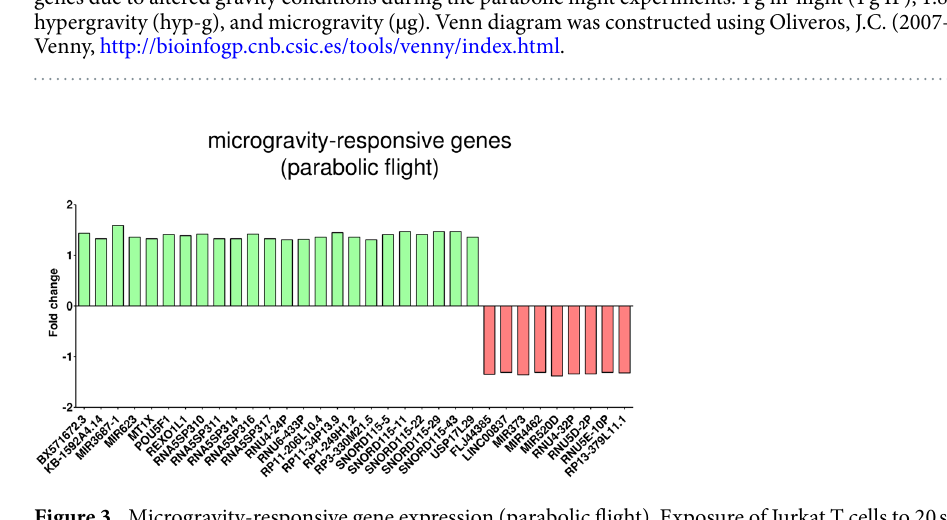
Figure 3. Microgravity-responsive gene expression (parabolic flight). Exposure of Jurkat T cells to 20 s of microgravity during the 23 rd DLR parabolic flight campaign led to 24 up and nine down-regulated genes when compared to the 1 g in-flight control (log2 values, p <